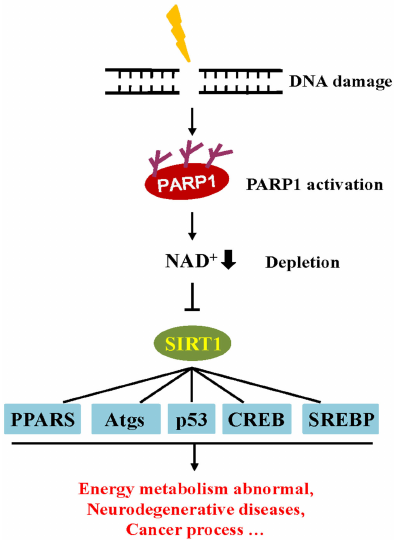
Figure 4. The crosstalk between PARP1 and SIRT1 in the DNA damage response. DNA damage activates PARP, leading to the depletion of NAD + and induced inactivation of SIRT1 activity, which in turn, influence protein targets involved in metabolic regulation. PPARs, peroxisome proliferator-activated receptors; Atgs, autophagy-related proteins; SREBP, sterol regulatory element binding protein; CREB, cAMP response element binding protein.